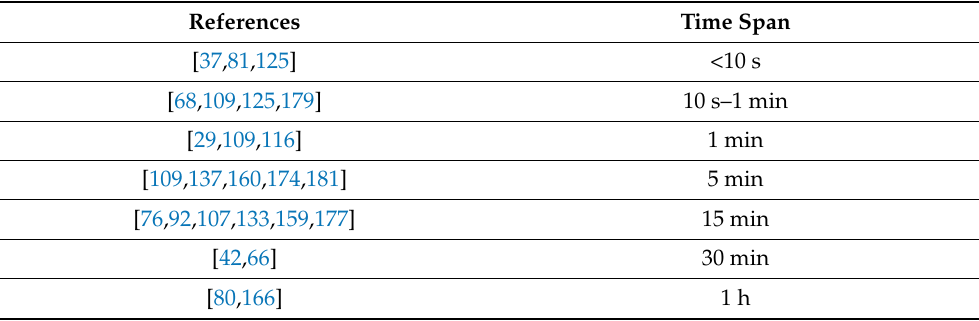
Table 2. Classification of online energy management problems by the time span of their updating